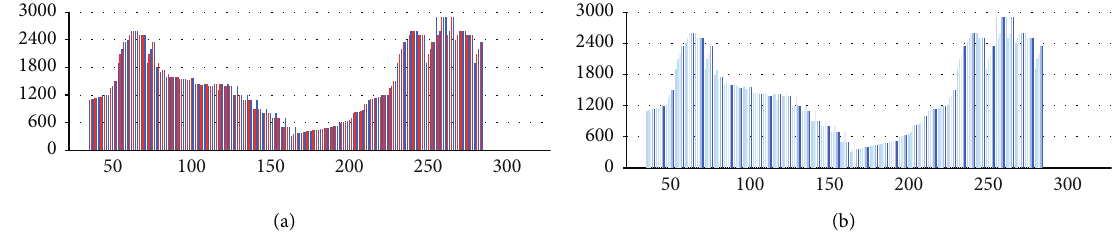
Figure 2: Arnold transform histogram: (a) original histogram; (b) scrambling encryption histogram.